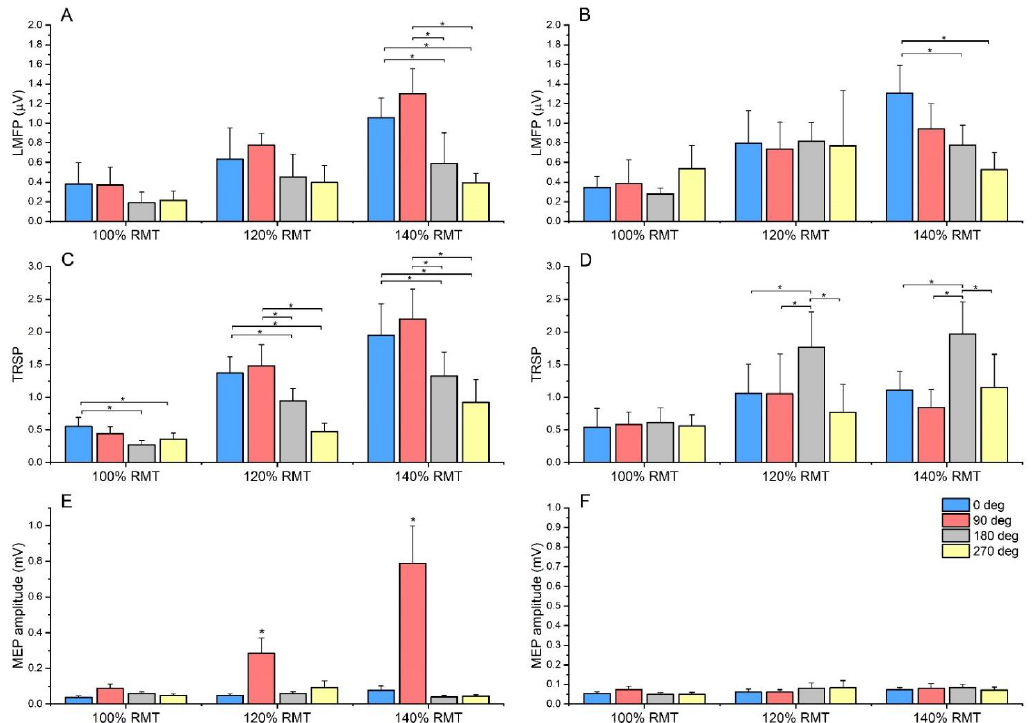
Figure 4. Summary of results on LMFP and TRSP. Panel ( A ): Early LMFP (10–70 ms) was larger at 0 ◦ and 90 ◦ compared with 180 ◦ and 270 ◦ . Although this was true for all the tested SIs, the effect reached statistical significance only at 140% RMT. Panel ( B ): Late LMFP (70–250 ms) evoked by 0 ◦ CO was larger than 180 ◦ and 270 ◦ , and again, this occurred only when an SI of 140% RMT was used. Panel ( C ): For TRSP in the β – γ frequency range, 0 ◦ CO induced a higher TRSP than 180 ◦ and 270 ◦ at 100% SI. At higher intensities, both 0 ◦ and 90 ◦ COs induced a higher TRSP compared with 180 ◦ and 270 ◦ . Panel ( D ): TRSP in the θ – α frequency range showed higher values for 180 ◦ compared with the other CO, both at 120% and 140% RMT SIs. Panel ( E ): MEP recorded from the left FDI were larger with 90 ◦ CO when using 120% and 140% RMT SIs compared with all other conditions. Panel ( F ): MEP recorded from the right FDI showed no difference across different CO and SI. Note: TRSP is expressed as the relative change compared with baseline. Error bars indicate the standard error of the mean. Asterisks indicate statistical significance (* p <